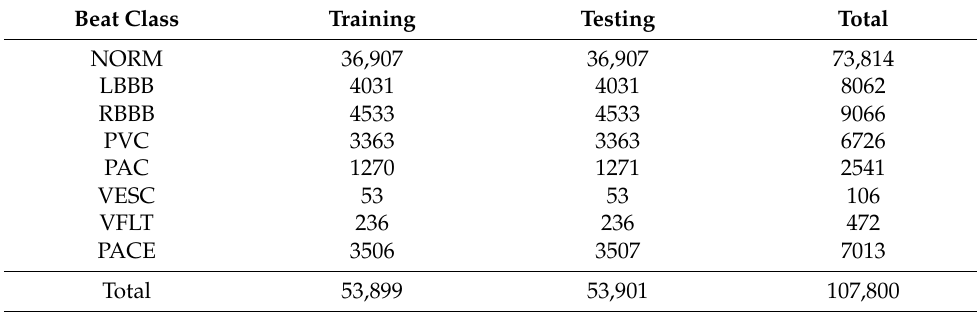
Table 2. MIT-BIH data selection